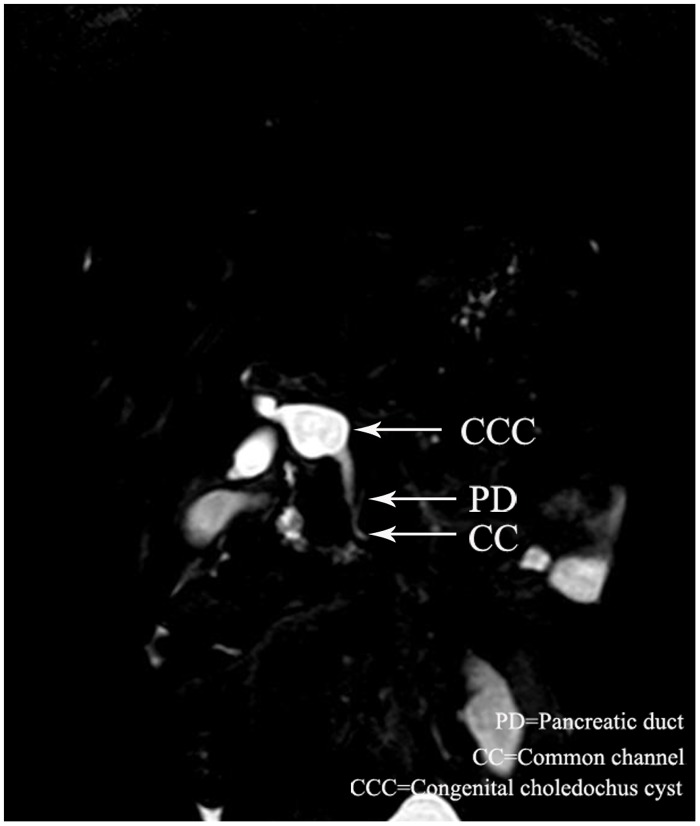
A 3-year old female with PBM, MRCP showed the gourd dilataion of the cyst.